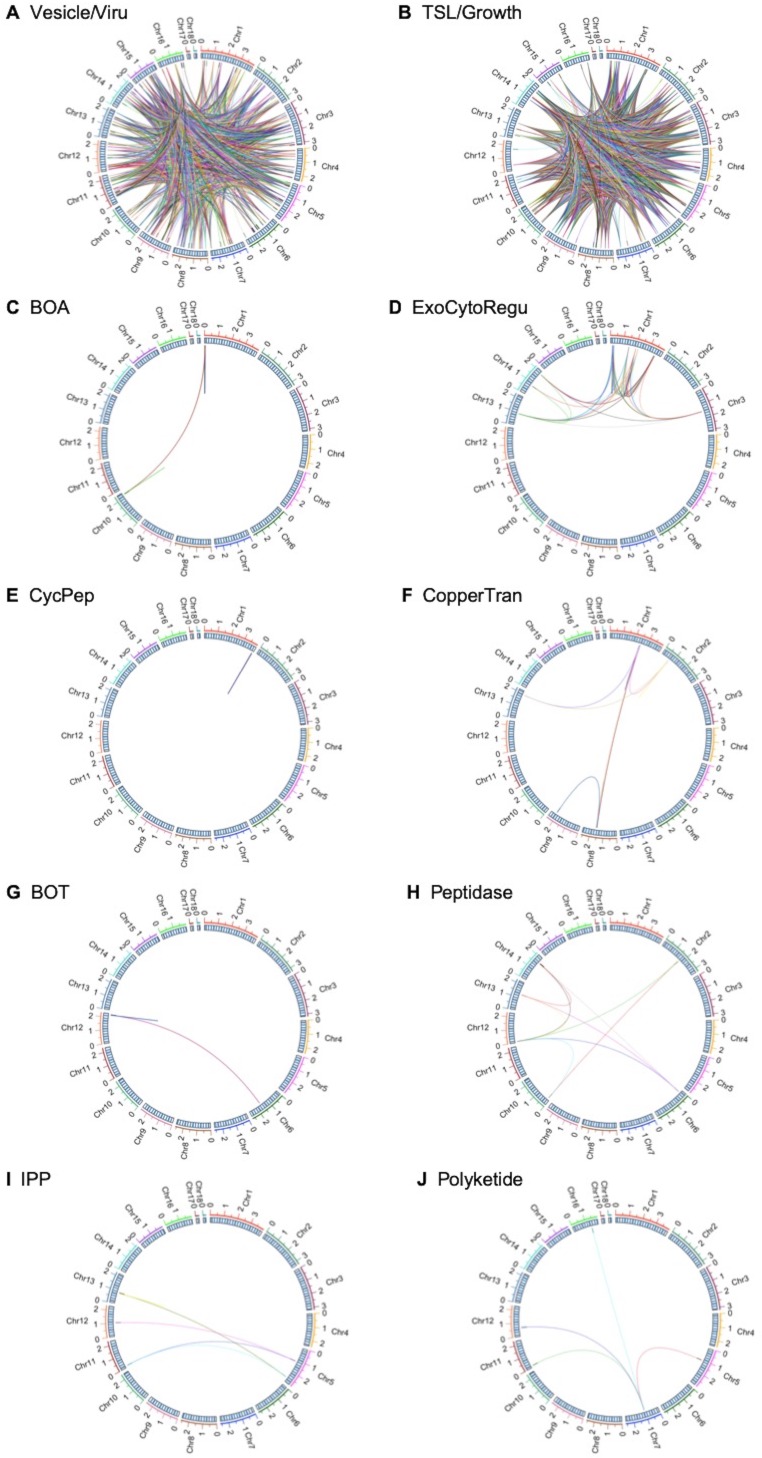
Genomic location of B. cinerea gene co-expression networks.The circle diagrams showed the genome-wide distribution of gene pairs identified by B. cinerea gene co-expression networks (GCNs) under Arabidopsis wild-type Col-0. (A) to (J) Genomic locations of gene pairs identified by GCNs: (A) Vesicle/virulence, (B) translation/growth, (C) botcinic acid (BOA), (D) exocytosis regulation, (E) cyclic peptide, (F) copper transport, (G) botrydial (BOT), (H) peptidase (gray), (I) isopentenyl pyrophosphate (IPP), (G) polyketide. The rings show 18 B. cinerea chromosomes on a Mb scale. Genomic locations of co-expressed gene pairs are connected by the colored lines.